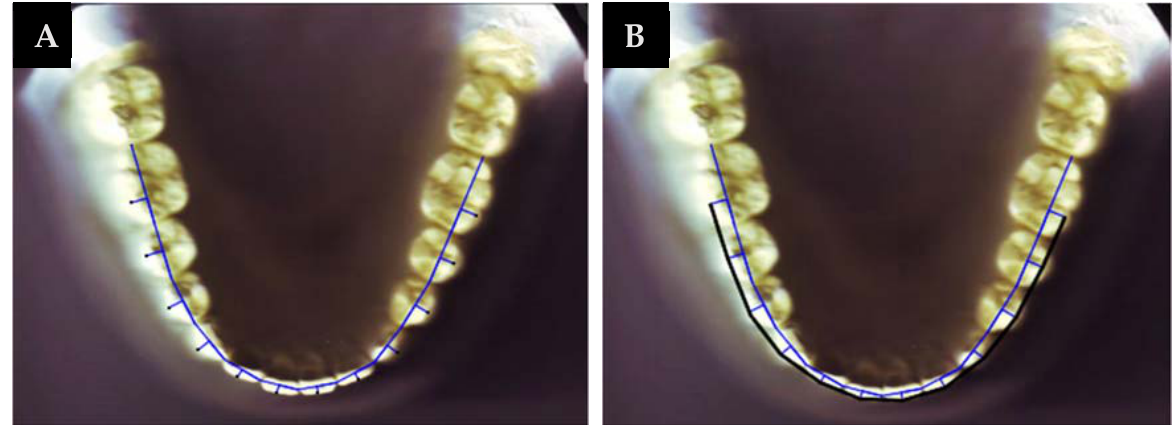
Figure 1. Digitized contact points on a mandibular cast.